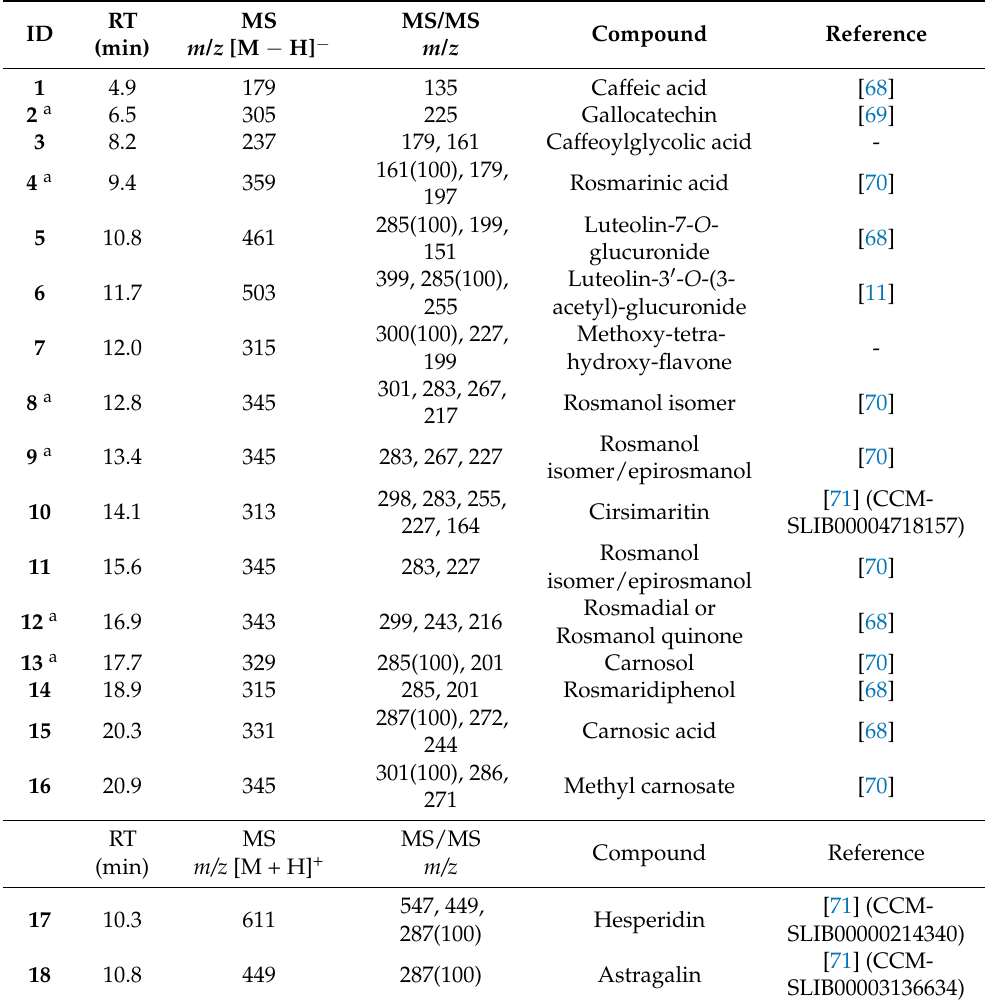
Table 2. Metabolites of Ro annotated by HPLC-ESI-MS/MS.